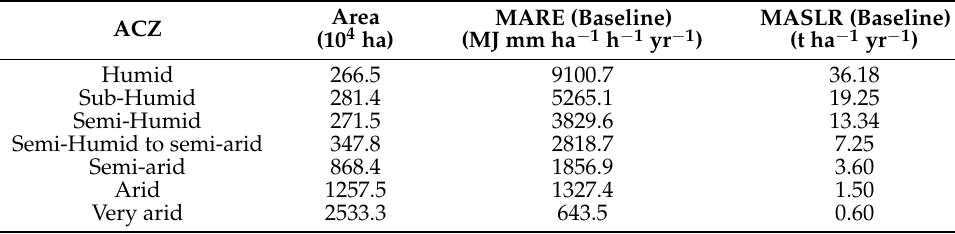
Table 6. Baseline soil erosion rates in different Agro-Climatic Zones in Kenya.